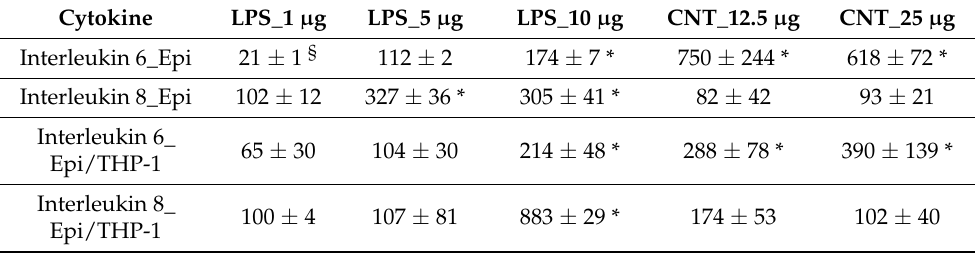
Table 7. Time-dependent changes (in %) of cytokine secretion by EpiAlveolar™ tissues without THP-1 (Epi) and with THP-1 (Epi/THP-1) upon stimulation with lipopolysaccharide (LPS) and CNT4003. Secretion of unstimulated tissues is set as 100%. Significant increases ( p < 0.05) between treated and untreated samples are indicated by an asterisk and significant decreases by a paragraph sign.